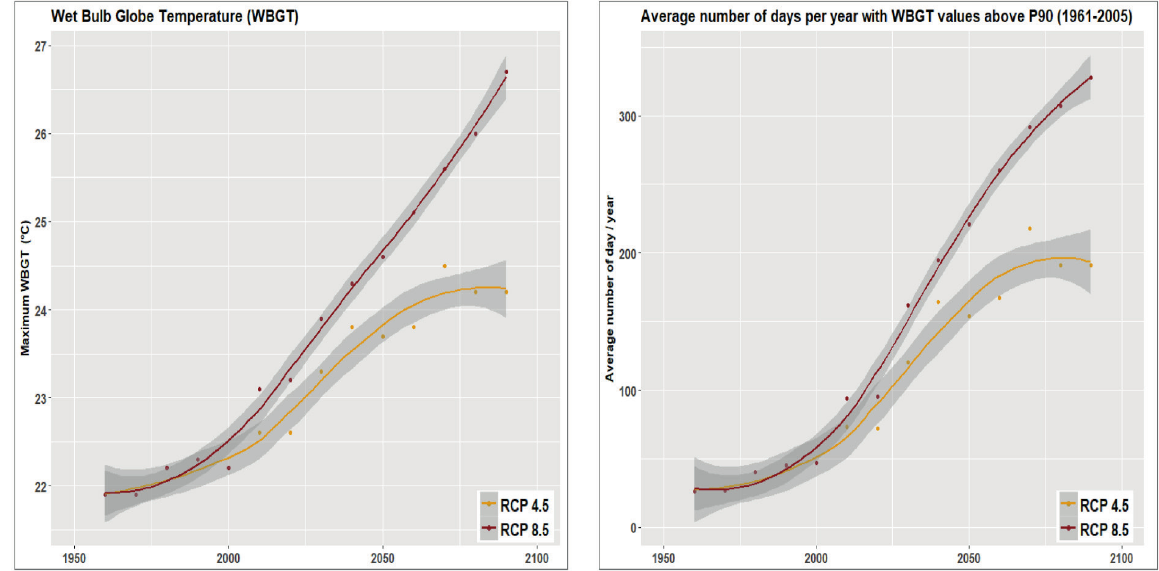
Figure 2 - Projections of the maximum wet bulb globe temperature (WBGt) and the average number of days in which the maximum WBGt exceeded the 90th percentile of the reference period